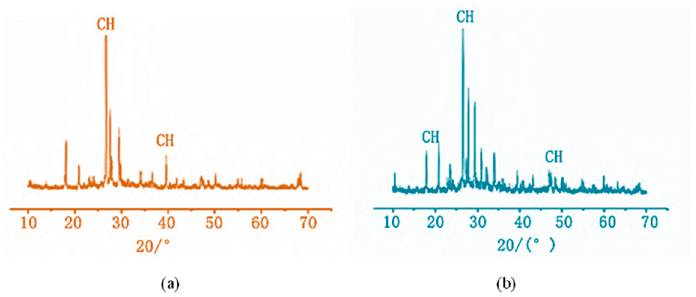
Figure 4. XRD patterns of shotcrete at different temperatures: ( a ) 30 °C, ( b ) 60 °C [45].